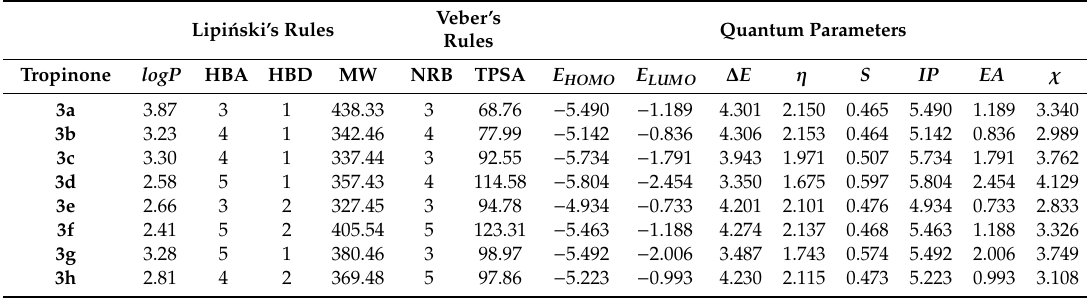
Table 1. Predicted molecular properties for compounds 3a – 3h . Veber’s Lipi´nski’s Rules